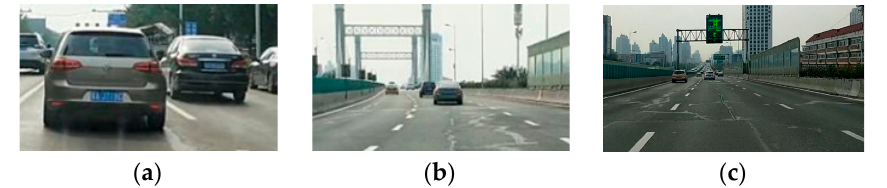
Figure 23. The distance of the preceding vehicle on the road. ( a ) The distance from the preceding vehicle of the road is about 3 m, and the taillight image is relatively clear; ( b ) The distance from the preceding vehicle of the road is about 30 m, and the taillight image can be distinguished; ( c ) The distance from the preceding vehicle of the road is about 60 m, and the taillight image is difficult to distinguish.